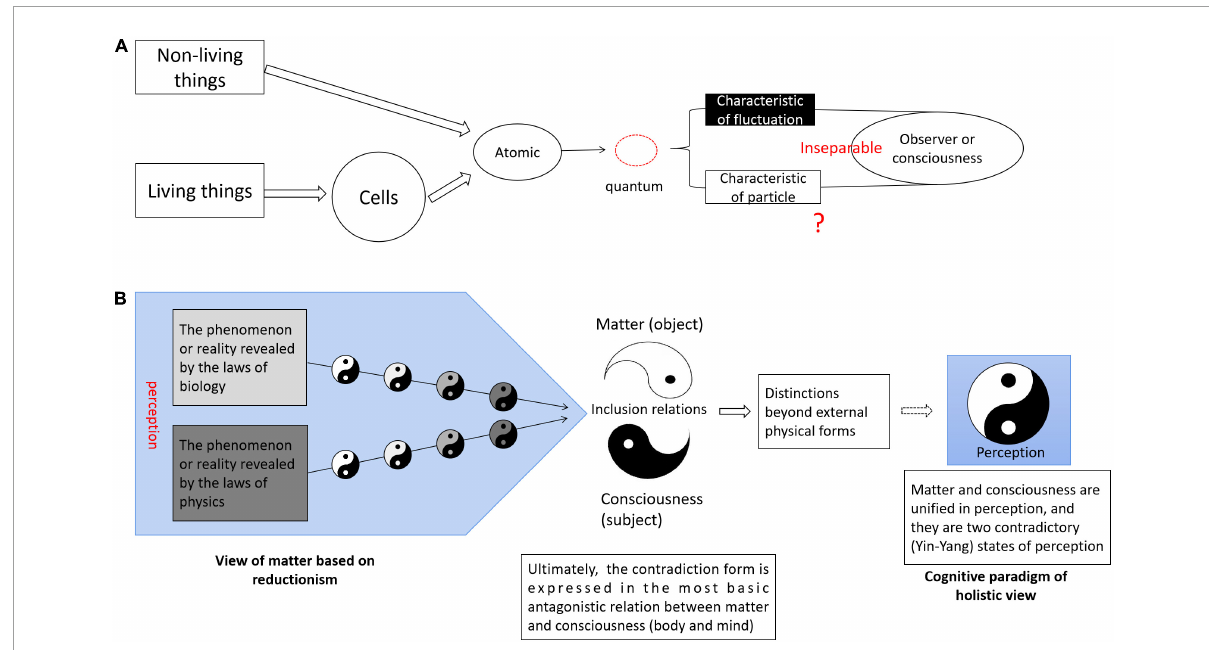
FIGURE5 Dilemmas of consciousness in biology and physics may be reconciled by the holistic cognitive paradigm. (A) Reductionism seeks to explain everything (the theory of everything has nothing to do with perception) by understanding the motion of microscopic atoms (quanta). Phenomena revealed by quantum mechanics, such as wave-particle duality, challenge this basic cognitive paradigm. The nature of a quantum (wave or particle) is inseparable from the observer (or consciousness). However, further mathematical descriptive theoretical framework based on this paradigm has not been established. (B) The reality revealed by biology and physics presents a regular paradigm shift trend and has similarities in terms of perception. The contradiction form (paradigm) in terms of perception gradually changes from obvious to the most basic, from concrete to abstract. Both disciplines ultimately reveal, respectively, the limitations of cognitive paradigms based on material view, reflecting the inclusive relationship between matter and consciousness (It was first believed that the objective material world had nothing to do with perception, and the two were opposites, using different ways of describing human society and nature). Following the previous paradigm, we conjecture that the next paradigm will not be described in concrete physical form, but in the paradigm evolution of reality based on perception and experience. In this paradigm, individuals are defined in terms of different fates and realistic outcomes rather than physical